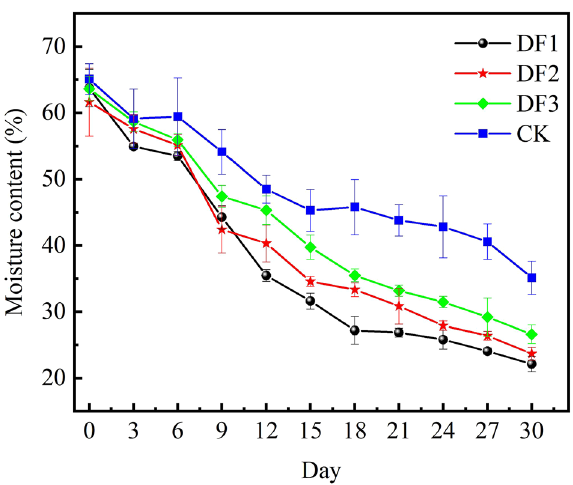
Figure 3. Changes of moisture content in different days of composting in each